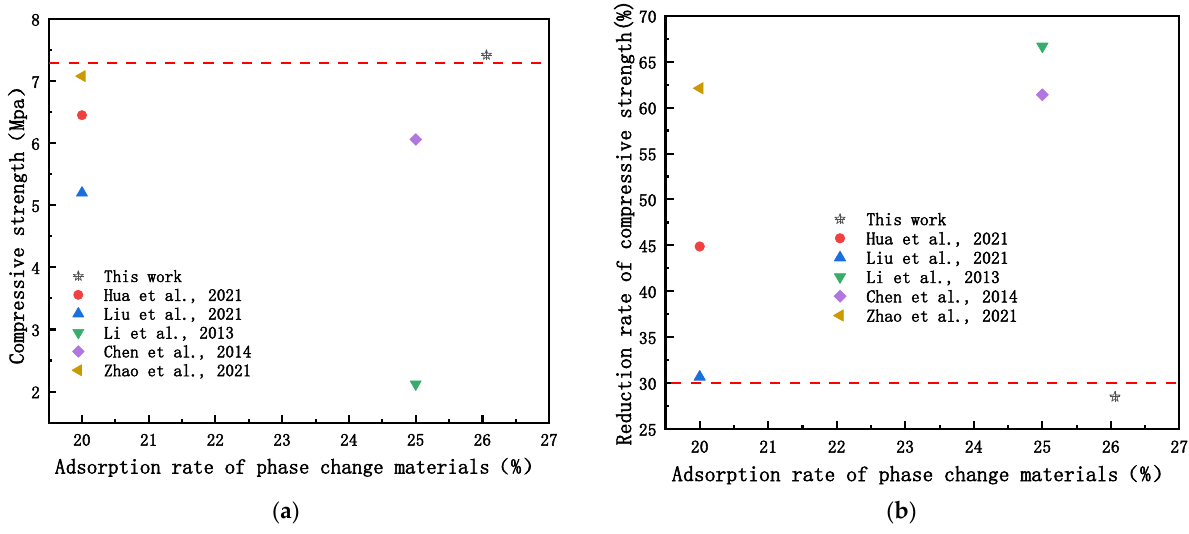
Figure 7. Comparison of existing studies: ( a ) compressive strength; ( b ) reduction rate of compressive strength [15 – 19].